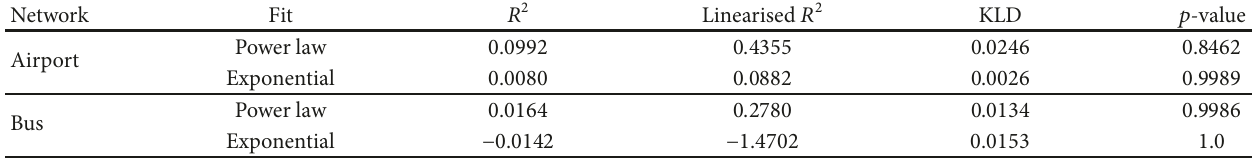
Table 1: Metrics of goodness-of-fit for the degree distributions of the two networks depicted in Figure